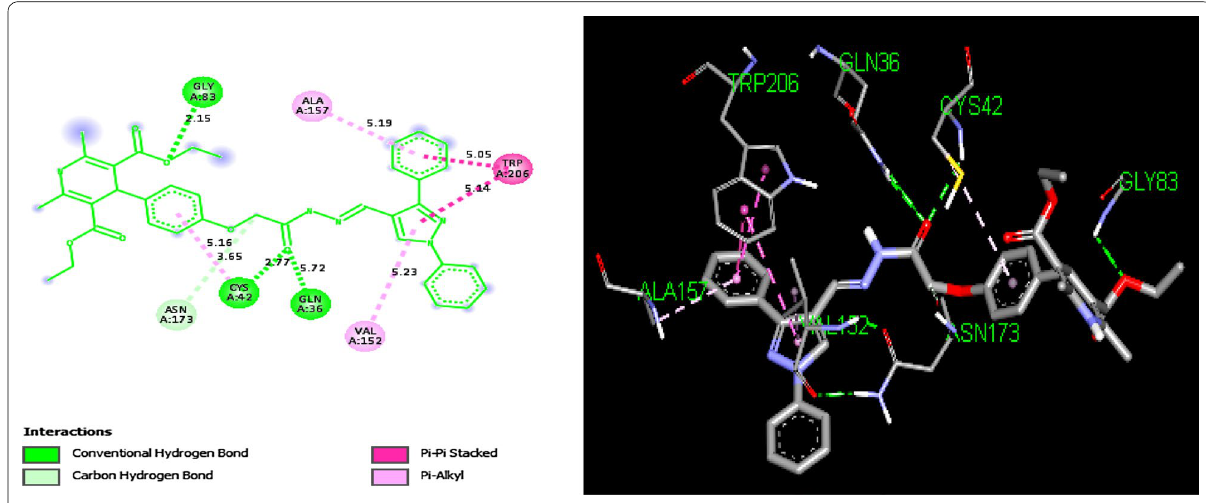
Fig. 8 Interactions of the 5d into the binding sites of FP-2 ( PDB ID: 3BPF